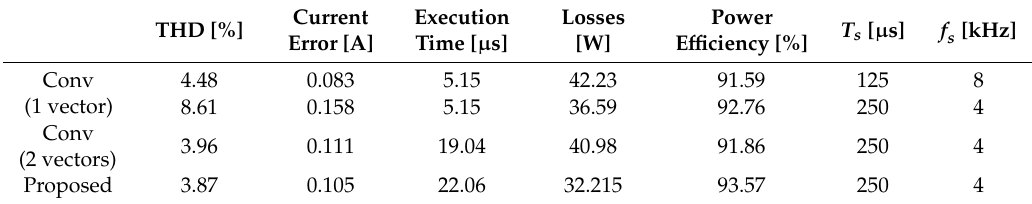
Table 2. Performance comparison of the conventional methods and the proposed method.